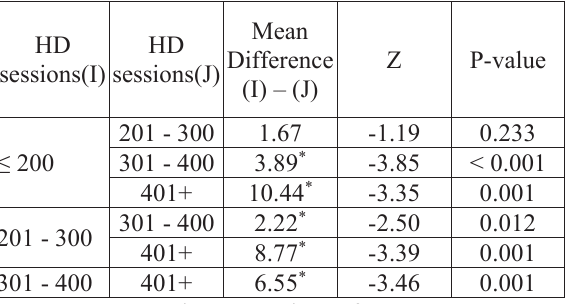
Table-5: Group wise comparison of TAPSE among 4